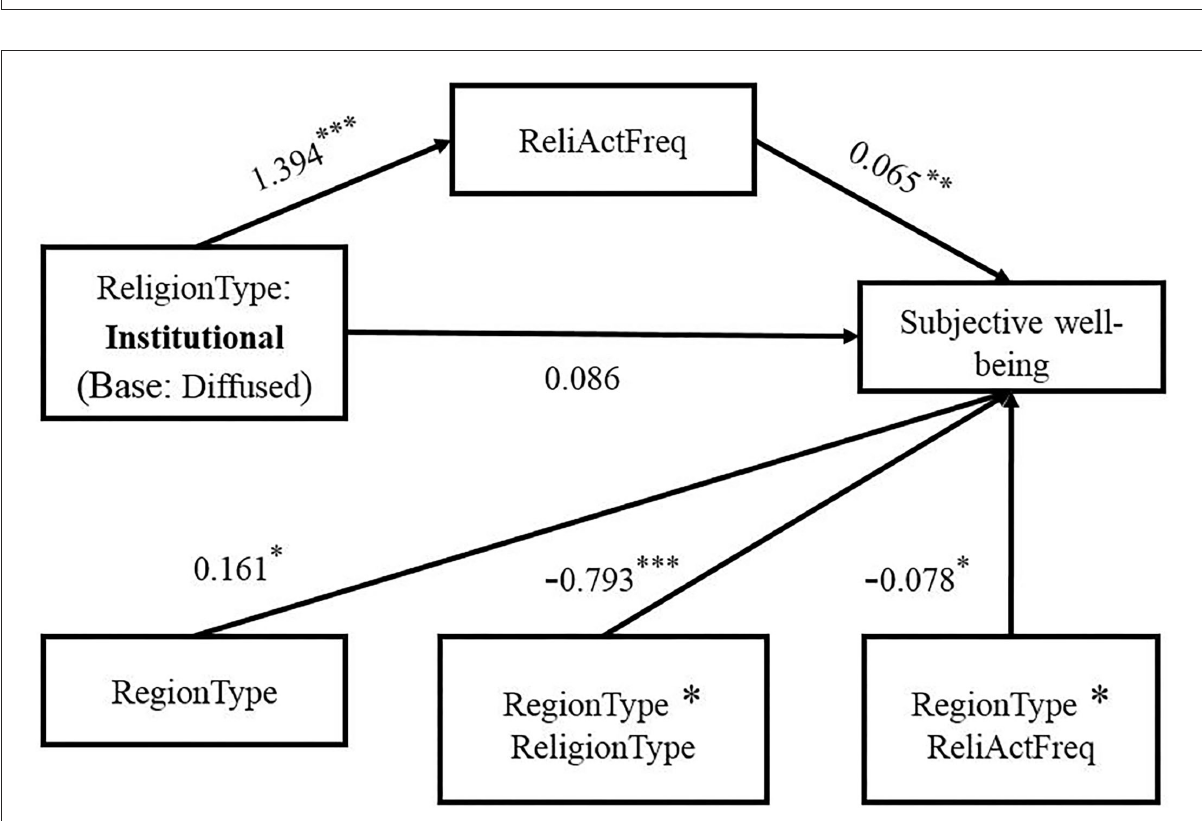
FIGURE2 The moderated mediation model. ReliActFreq, religious activity frequency. * p < 0.05, ** p < 0.01, *** p < 0.001.